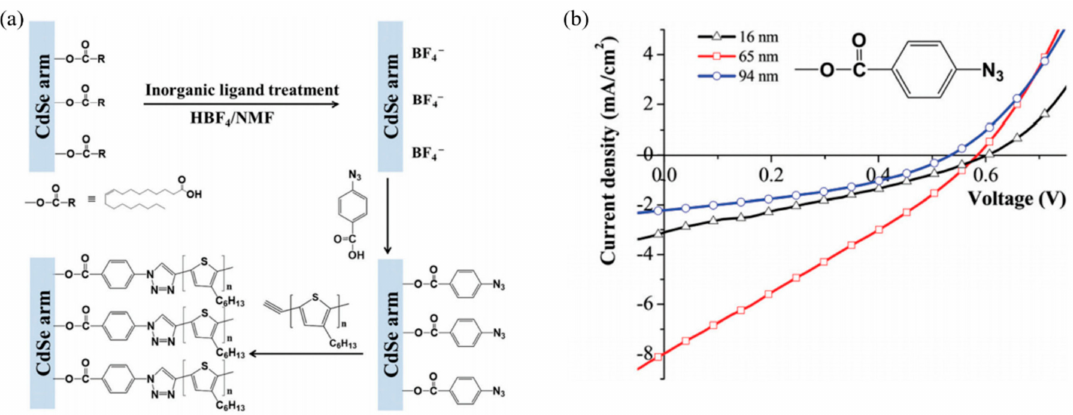
Figure 14. ( a ) Illustration of the formation of P3HT-CdSe tetrapod nanocomposites; ( b ) current–voltage plot of hybrid solar cells. Reprinted with permission from [48]. Copyright 2016, Royal Society of